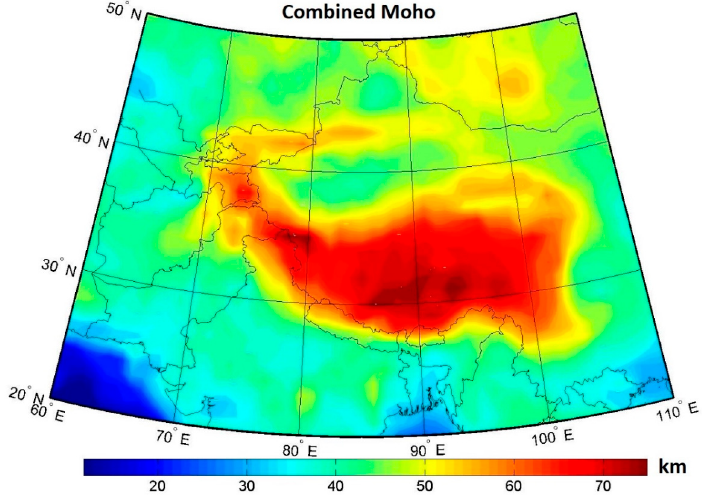
Figure 4. Combined gravimetric-seismic Moho model of Tibet.